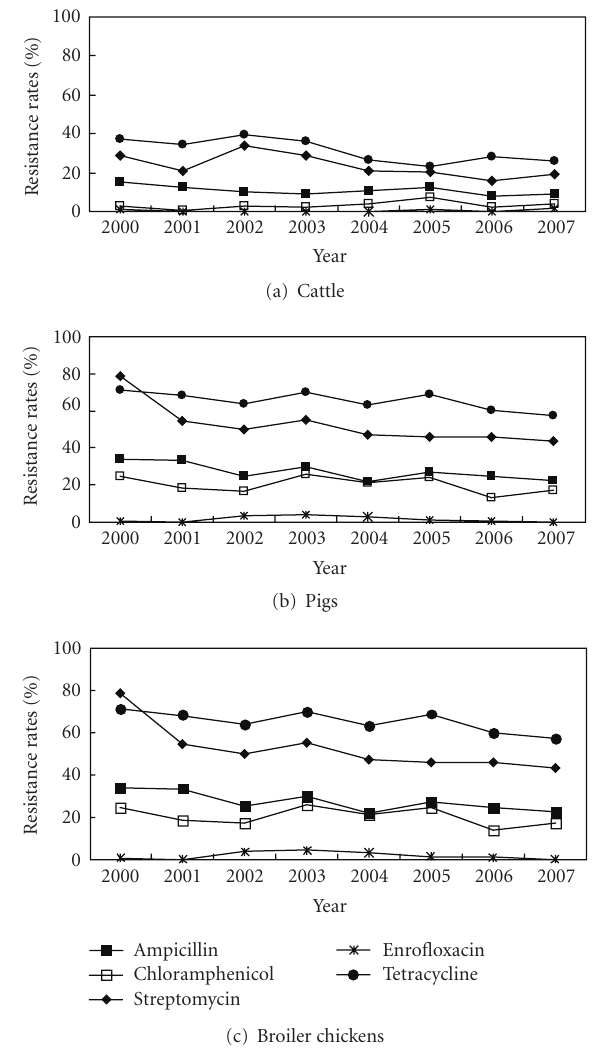
Figure 3: Trends in resistance to selected antimicrobials among commensal E. coli isolates from cattle, pigs, and broiler chickens in